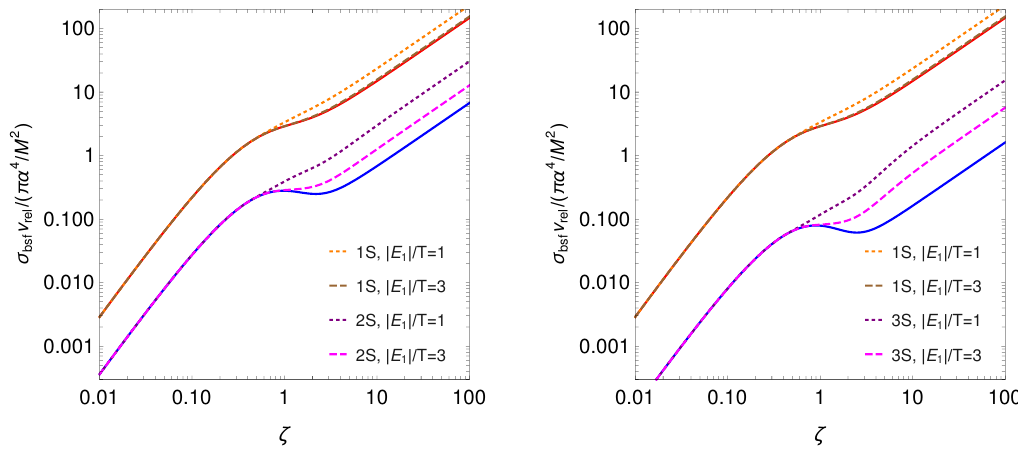
Figure 4 . Bound-state formation cross section, normalized by the factor πα 4 /M 2 , for the 1 S and 2 S states as function of ζ (left plot). Two choices for | E 1 | /T are considered. The comparison between the 1 S and 3 S states is shown in the right plot.